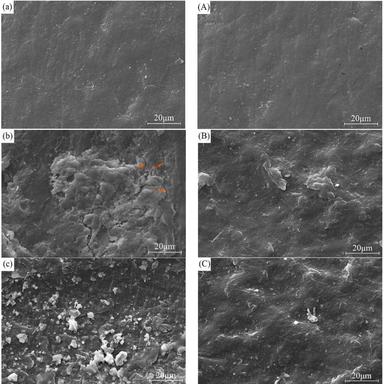
SEM surface images of PE pipes: unaged PE80 (a), after 10,104 h (b), service 25 years (c) and unaged PE100 (A), after 10,104 h (B) and service 15 years(C).